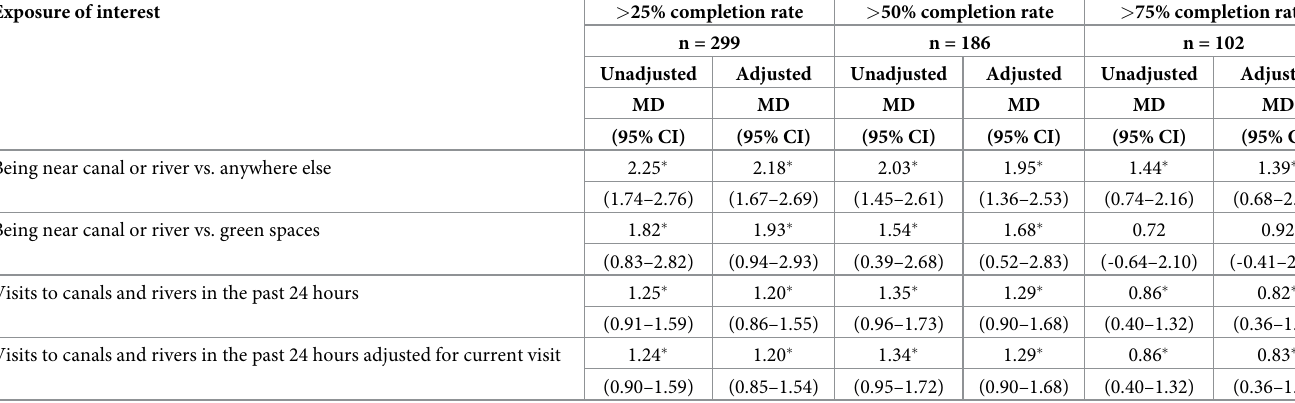
Table 2. Associations between visiting canals and rivers and subjective mental wellbeing. Exposure of interest